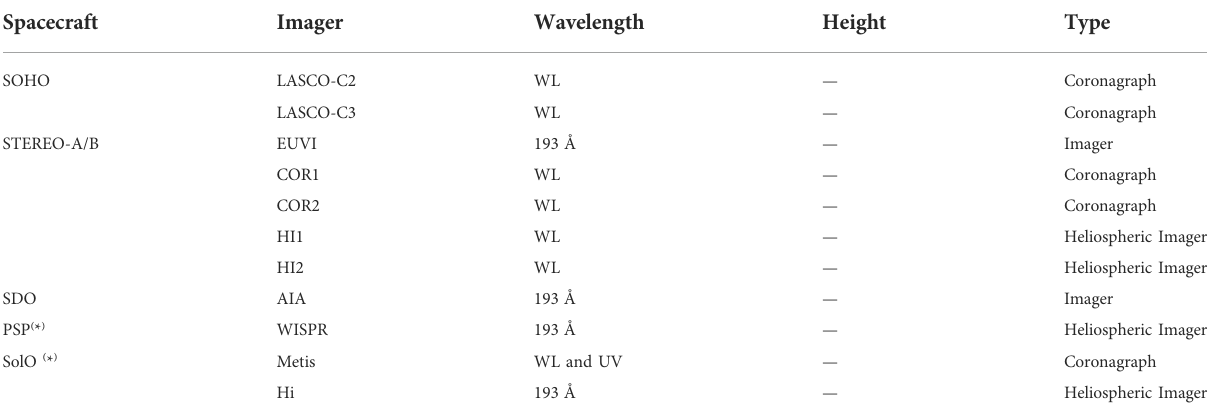
TABLE 1 A list of the available imagers used in